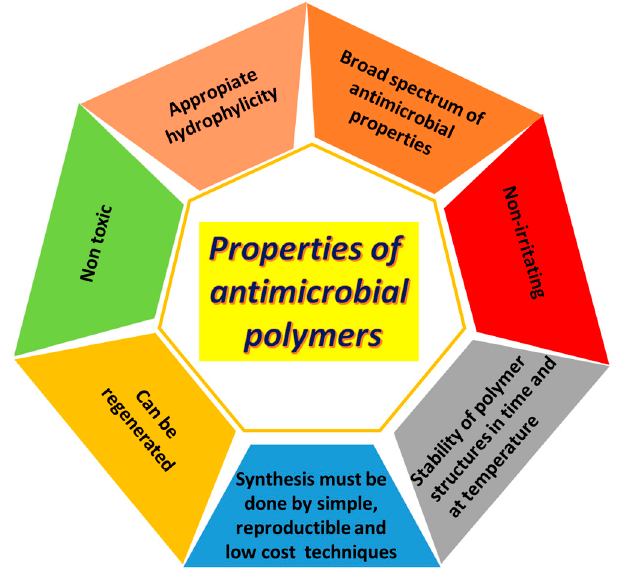
Figure 3. Requirements for an effective antimicrobial polymers.